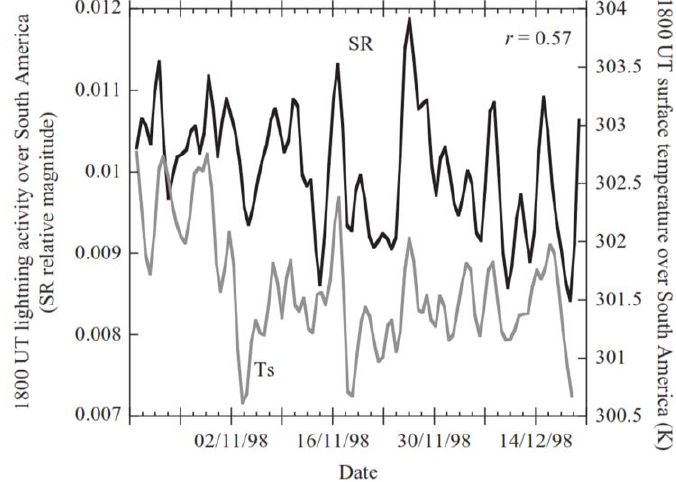
Figure 8: Relative amplitude of the 8 Hz SR signal at 1800 UT every day, arriving from South America, but detected in Israel (black), compared with the spatially averaged 1800 UT tropical land surface NCEP temperatures over South America (gray).